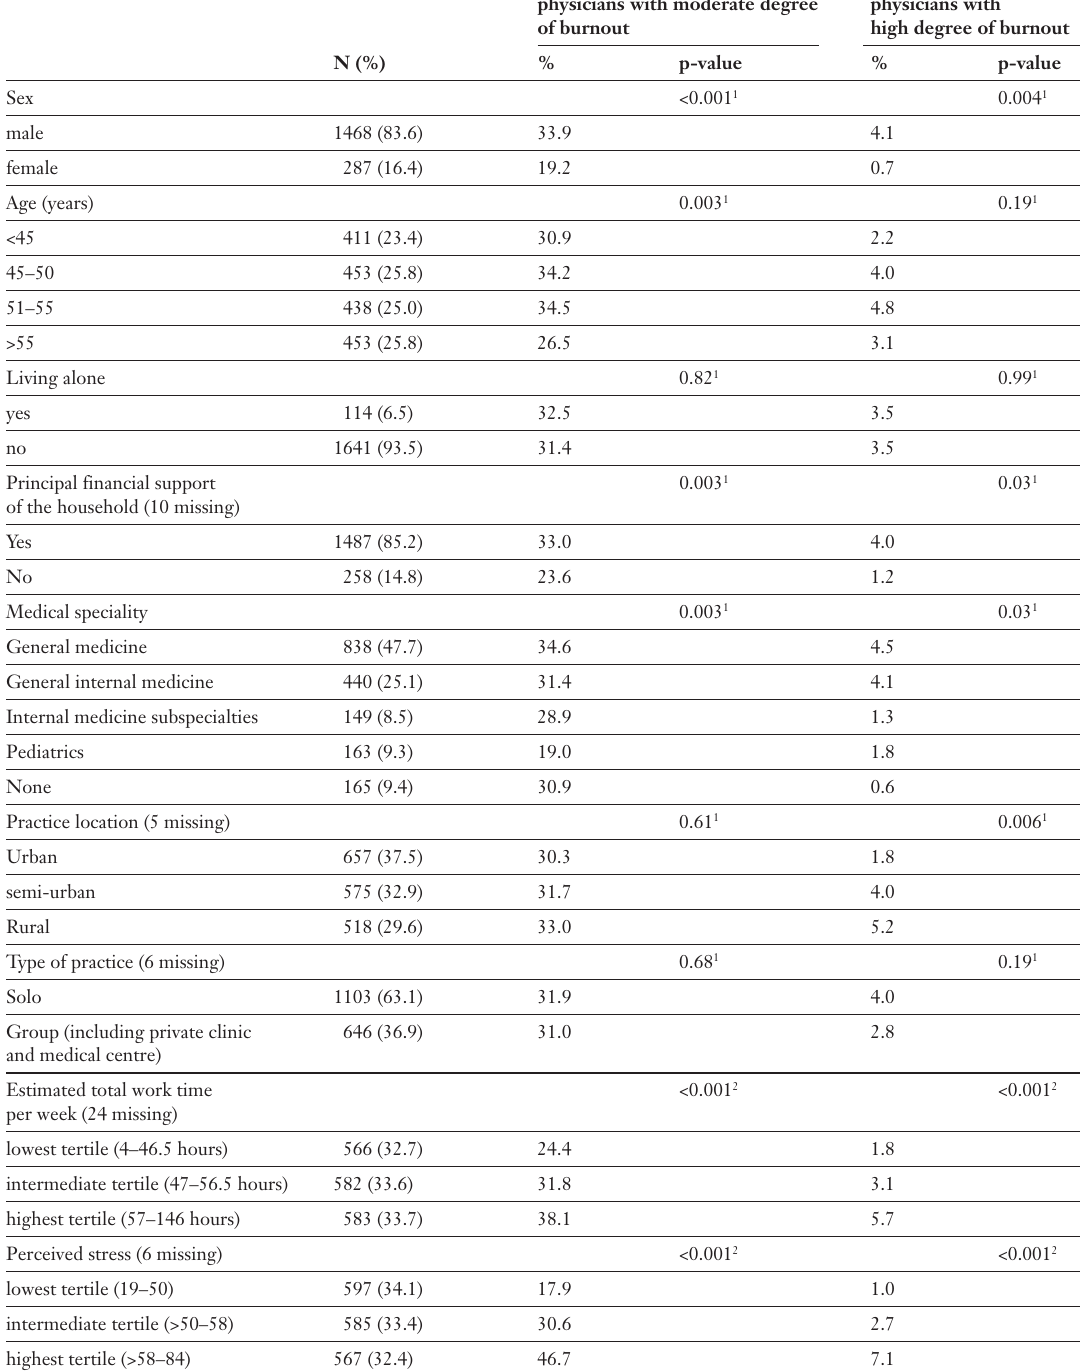
Relationships of burnout to socio- demographic charac- teristics for 1755 Swiss primary care